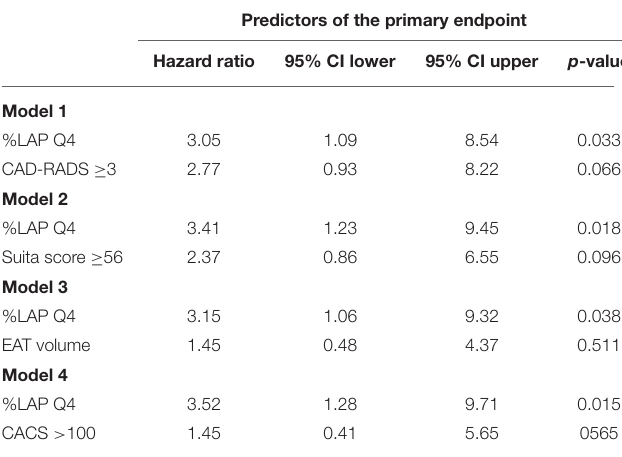
TABLE 4 | Multivariable Cox hazard model for the prediction of the primary and secondary endpoints during follow-up.